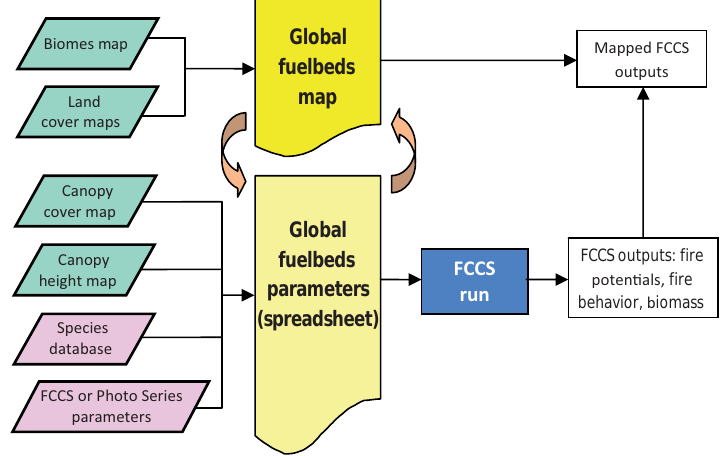
Figure 1. General flowchart of the methodology used for the generation of the global fuel data set. More detailed steps are shown in Figs. 2 and 3.